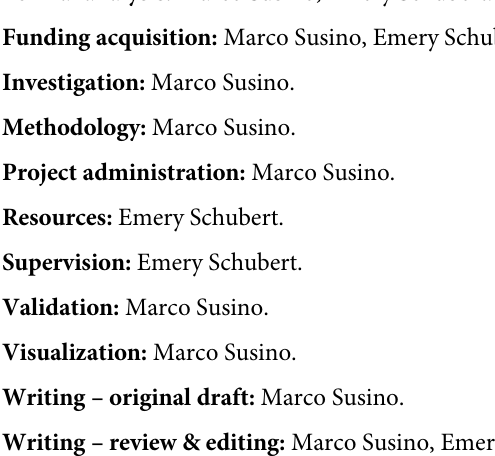
S2 Table. Music excerpts (exemplars) used in phase 1 to elicit spontaneous emotion responses to a given genre. S3 Table. Terms and synonyms identified through the english oxford living dictionary and matched in ANEW 2017. S4 Table. Emotions and respective percentages reported above 5% of the total emotion words for each genre by culture for phase 3